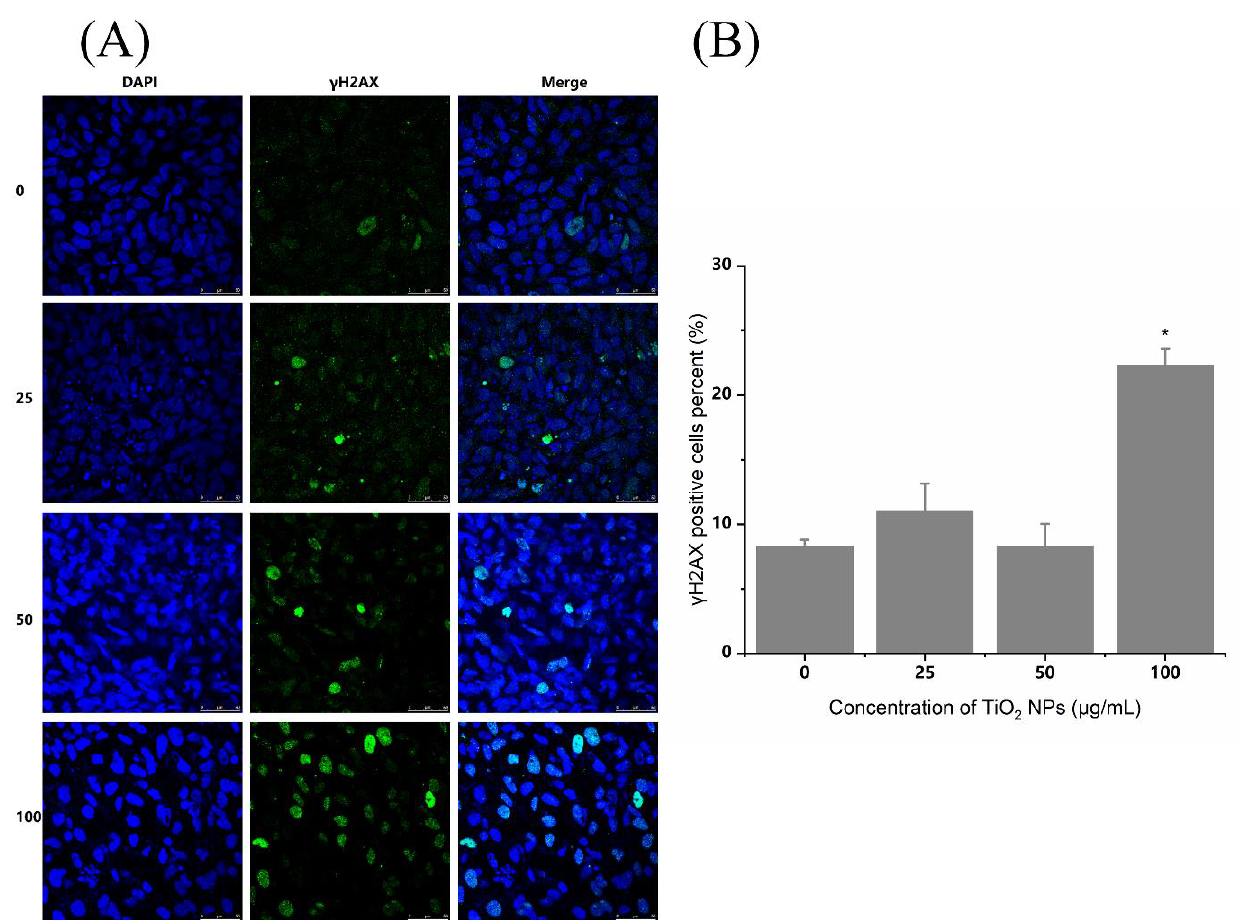
Figure 5. Effects of TiO 2 NPs on intracellular γ -H 2 AX in BEAS-2B cells. As a marker of DNA double-strand breaks (DSBs), γ -H 2 AX was detected by indirect immunofluorescence staining after exposure to TiO 2 NPs at doses of 25, 50 and 100 µ g/mL for 48 h. ( A ) The γ -H 2 AX stained with green fluorescence was mainly distributed in the nucleus stained with blue DAPI fluorescence. ( B ) The percent of γ -H 2 AX positive cells increased significantly in the 100 µ g/mL TiO 2 NP group, compared with the control group. Significant difference from the control (* p < 0.05).